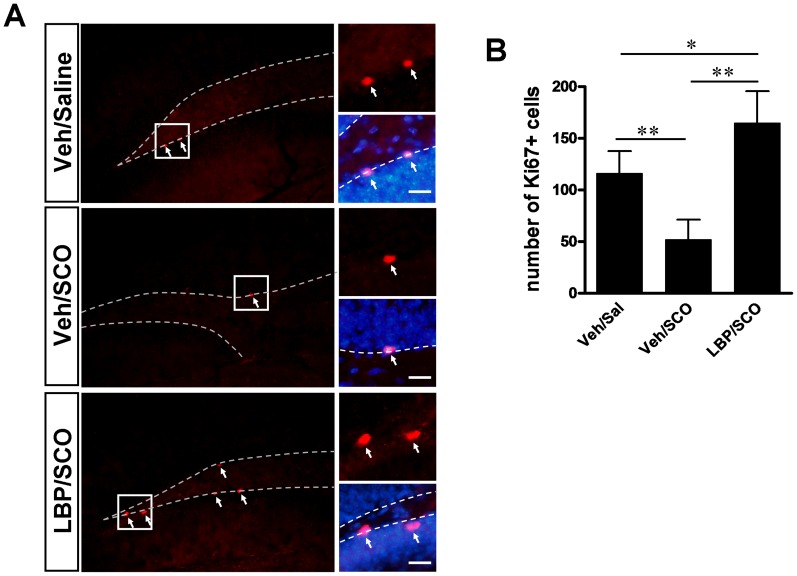
Effect of SCO/LBP treatments on cell proliferation in the hippocampal dentate gyrus (DG).(A) Representative immunofluorescence staining for Ki67, a marker of cell proliferation. Sections were subjected to Ki67 antibody after SCO or/and LBP treatment. Arrows indicate Ki67-positive cells in hippocampus. The dashed line is the location of subgranular layer in DG. (B) Quantification of Ki67-positive cells in the DG in A. SCO treatment significantly decreased cell proliferation compared to the vehicle/saline group. The LBP/SCO group showed a significantly higher proportion of Ki67-positive cells than the SCO group. Values are means ± SEM (n = 6 animals per groups); *,P<0.05; **,P<0.01; scale bars, 50 µm.